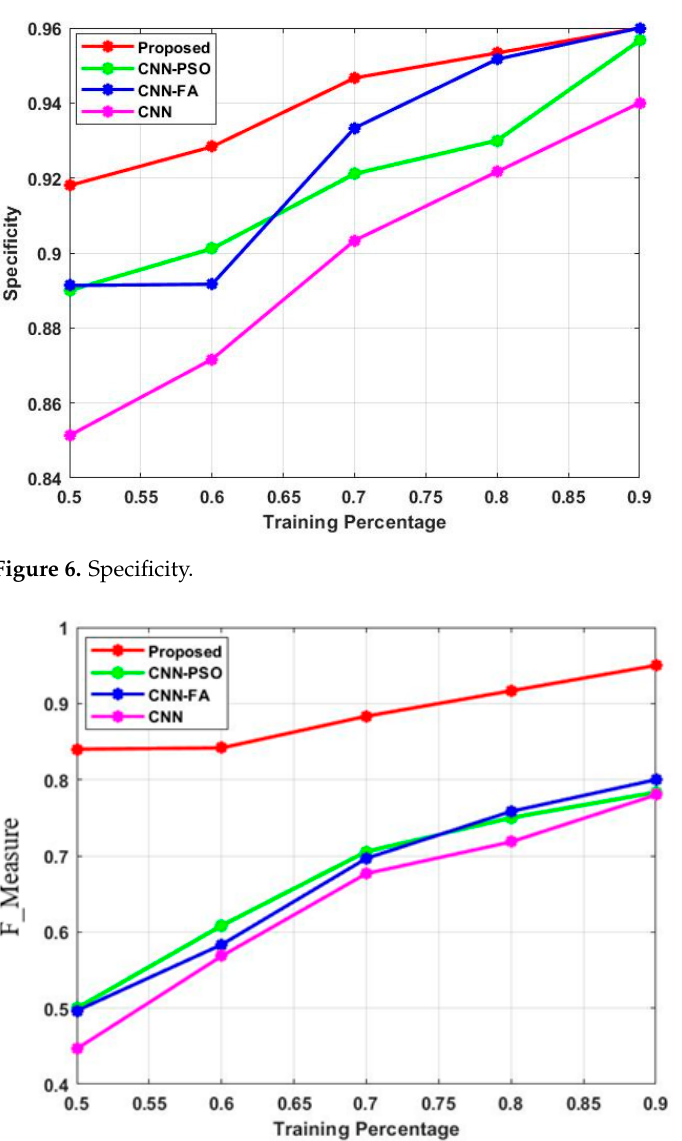
Figure 7. Figure 7. F_Measure. Figure 7. F_Measure.